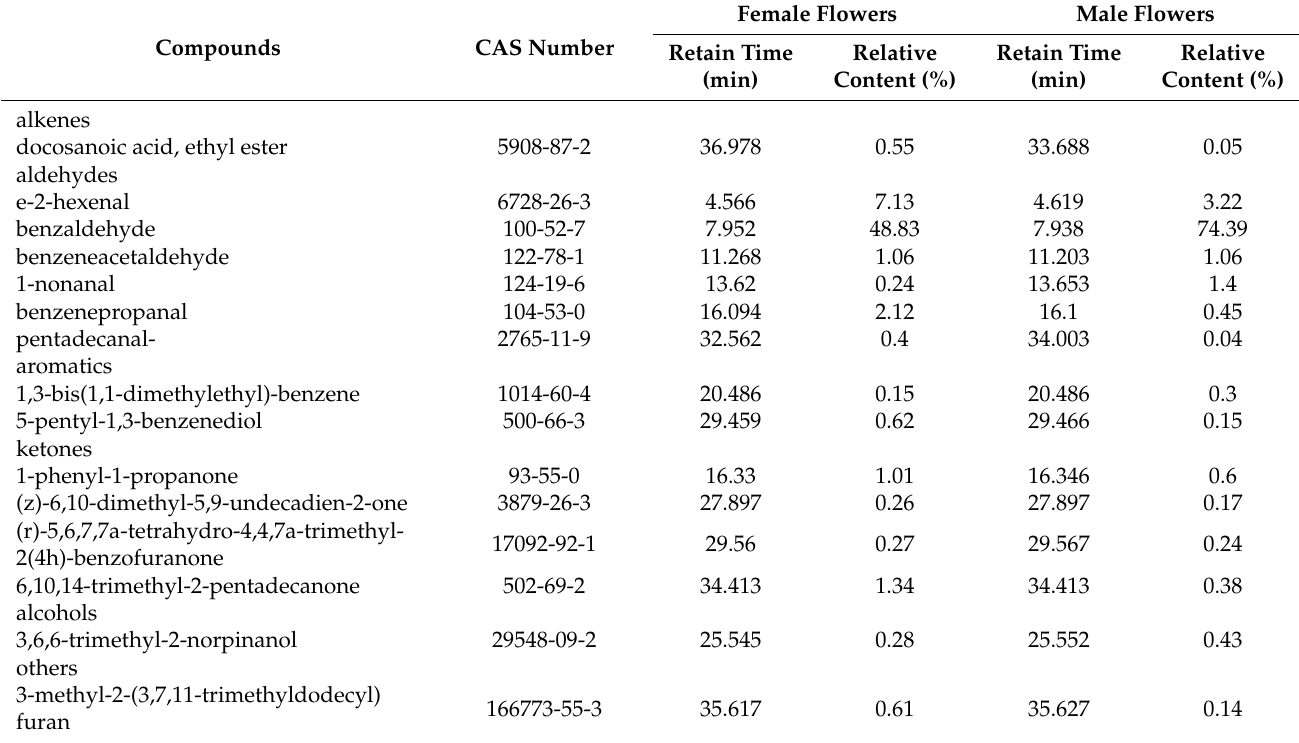
Table 3. Both female and male melon flowers contain volatile